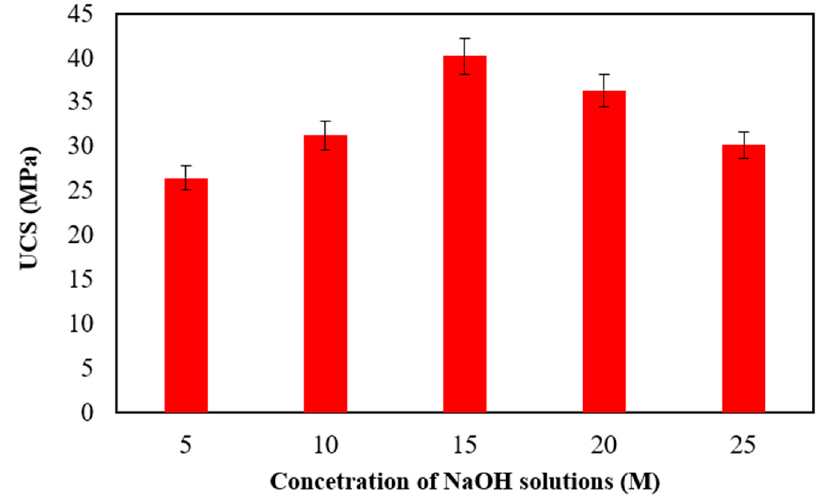
Figure 3. The effect of variation of NaOH solution concentration on UCS.